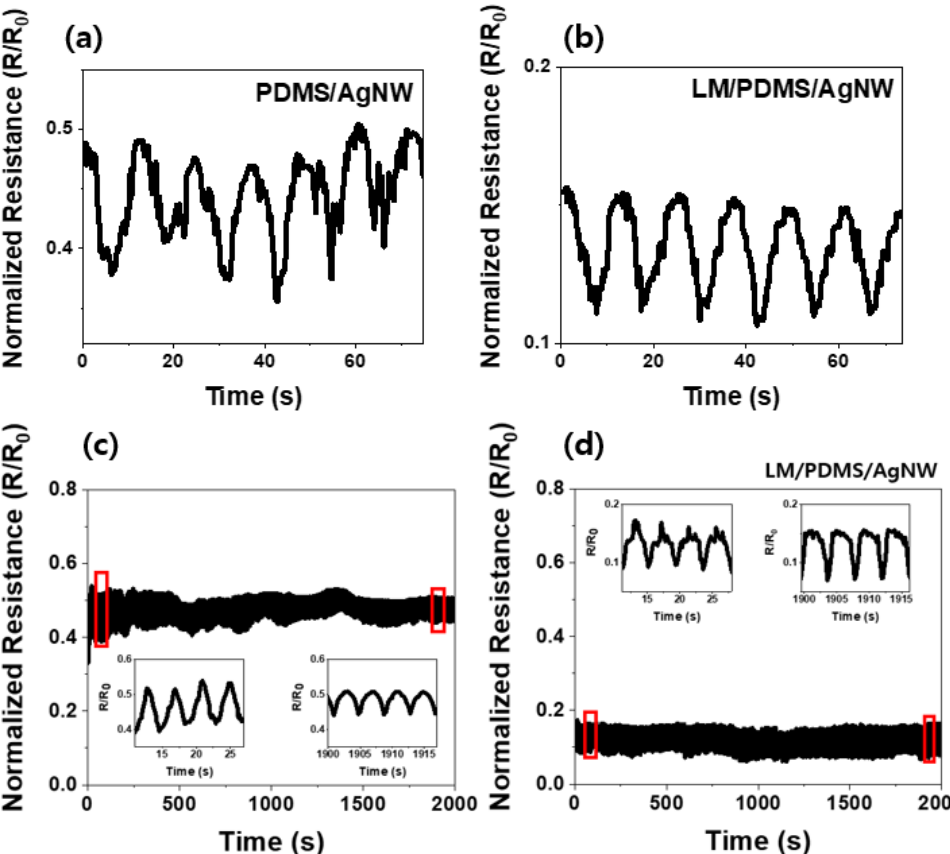
Figure 5. Normalized resistance versus time of PDMS/AgNW and LM/PDMS/AgNW sensors under applied pressure: low-speed cyclic test (six cycles) of ( a ) PDMS/AgNW and ( b ) LM/PDMS/AgNW sponges. High-speed cyclic test (500 cycles) of ( c ) PDMS/AgNW and ( d ) LM/PDMS/AgNW sponges. The insets show magnified views the regions outlined in red.